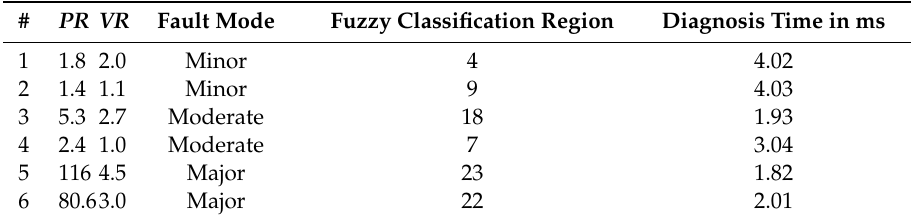
Table 5. Fuzzy classification test cases from the hardware implementation.